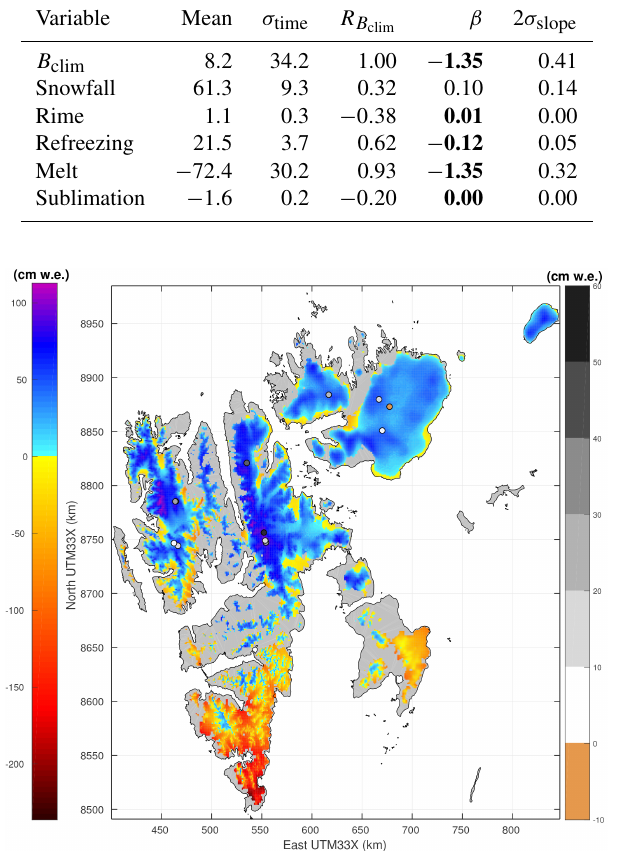
Figure 6. Map of simulated specific climatic mass balance ( B clim ) averaged for the period 1957–2014 in cmw . e . yr − 1 (colour scale on the left side). Circles indicate difference between modelled B clim and the ice-core-derived B clim (colour scale on the right side). For several ice cores, mass balance estimates are available for different time periods; here we only show the longest period; see Table 7 for